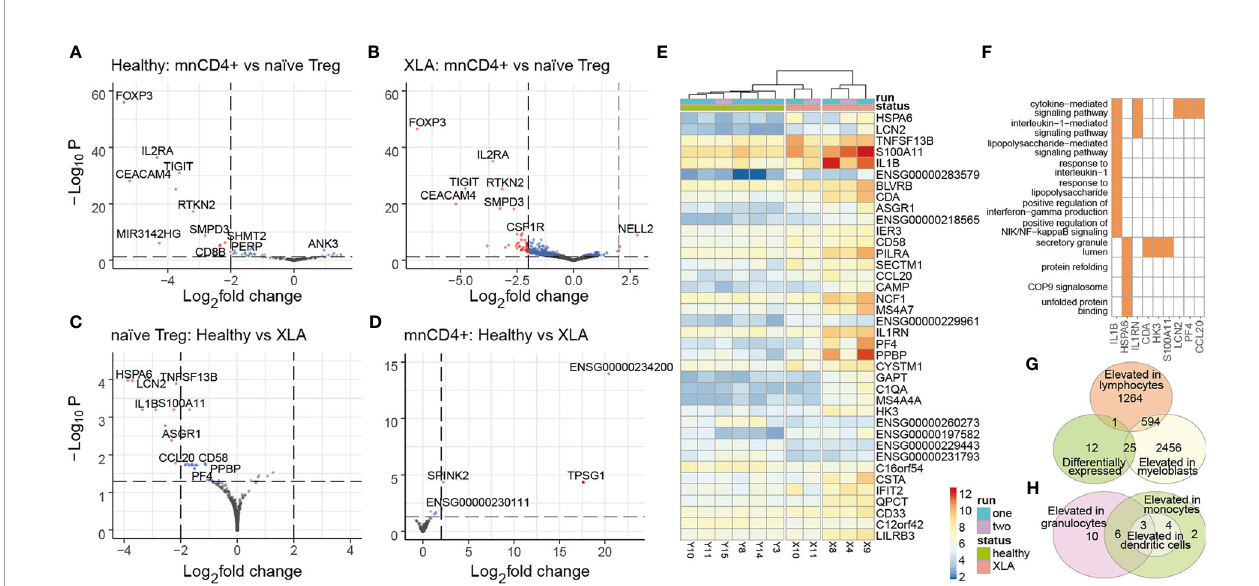
FIGURE 5 | Gene expression analysis in naïve T regs . Differential gene expression analysis of naïve T regs and mnCD4 + subpopulations in healthy donors (A) and patients with XLA (B) was performed using DESeq2. Red and blue dots show differentially expressed genes based on p adj < 0.05; red dots indicate transcripts based on absolute value of log2 fold changes >2. Adjusted P values were obtained using the Benjamini-Hochenberg procedure. Shrunken log2 fold changes were calculated using the ashr estimator, with mnCD4 + gene expression as numerator and naïve T reg gene expression as denominator. (C) Differential gene expression analysis of naïve T reg and (D) mnCD4 + with the healthy group as numerator and XLA as denominator. Colored dots highlight transcripts overexpressed in XLA naïve T reg (p adj < 0.05), red dots mark genes with log2 fold changes >2. (E) Heatmap of differentially expressed genes for naïve T reg cells from XLA and healthy donors. Data was prepared by DEseq2 as described in the Material and Methods section. (F) GO-enriched terms and input genes that are highly expressed in XLA naïve T reg . Enrichment analysis was performed by path fi ndR package, with 0.05 threshold for p-adj following DESeq analysis. (G) Venn diagram of XLA naïve T reg differentially expressed transcripts, showing intersection with genes that are usually expressed in myeloblasts or lymphocytes, or (H) intersection with genes usually elevated in granulocytes, dendritic cells, or monocytes according to